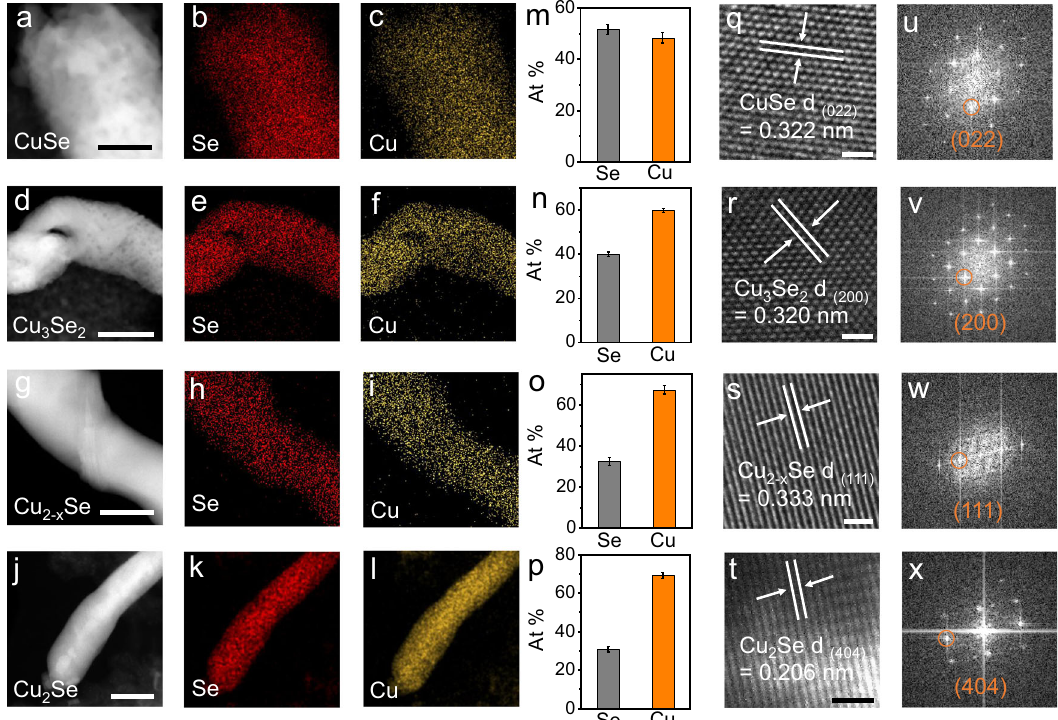
Fig. 5 Ex situ TEM measurements of the Se@C-based electrode. The low-resolution TEM images, corresponding element mapping images, and atomic ratio of ( a – c , m ) CuSe, ( d – f , n ) Cu 3 Se 2 , ( g – i , o ) Cu 2-x Se, and ( j – l , p ) Cu 2 Se; Error bars represent the standard deviation of different experiments. The atomic ratio high-resolution TEM images and corresponding Fast Fourier transform (FFT) patterns of ( q , u ) CuSe, ( r , v ) Cu 3 Se 2 , ( s , w ) Cu 2-x Se, and ( t , x ) Cu 2 Se, respectively. The scale bars are 100 nm in Fig. 5a, d, g, j, and 1 nm in 5q, r, s,